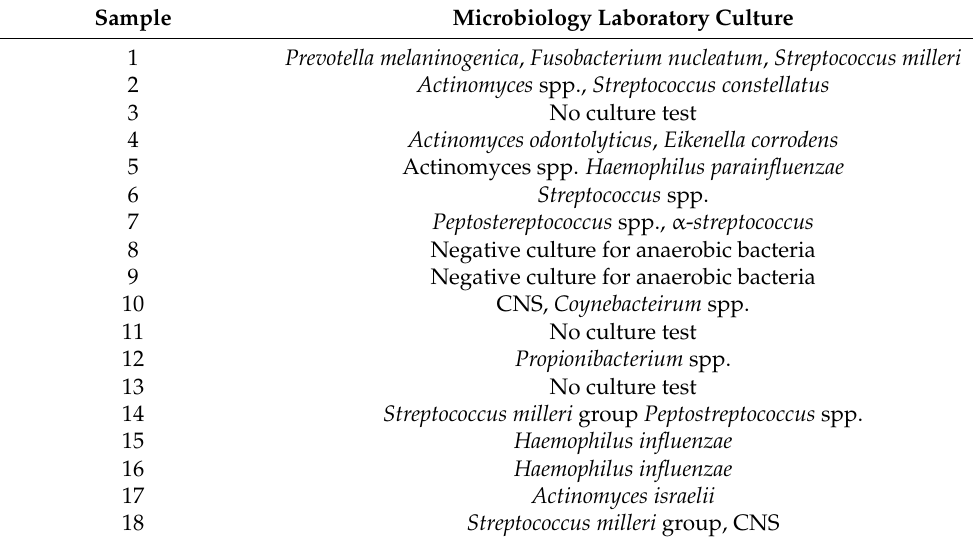
Table 2. Summary of microbiology laboratory culture of canalicular concretions.